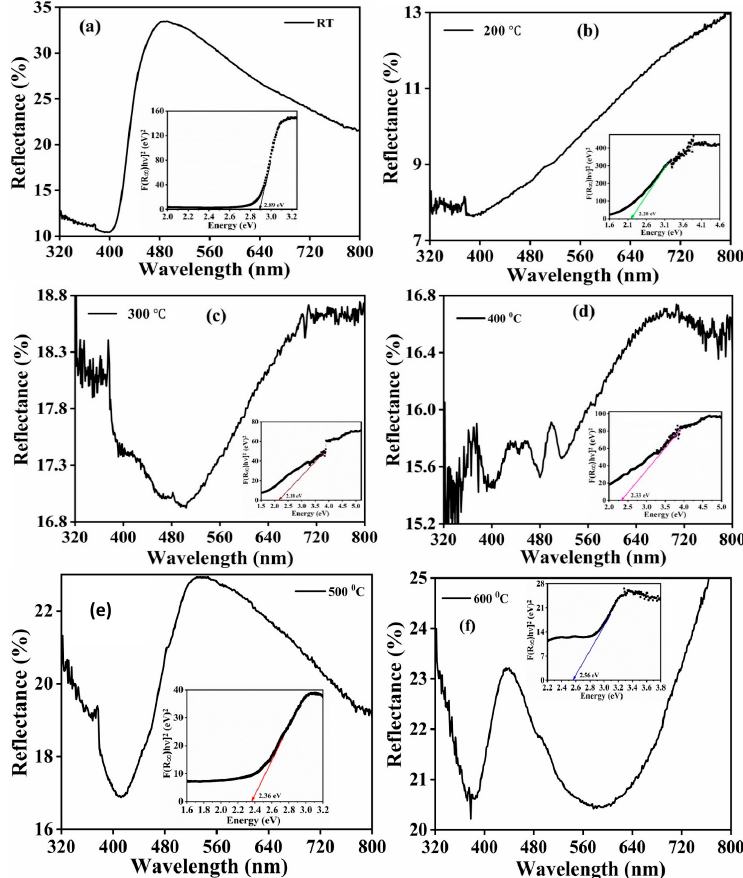
Figure 20. DR spectra of Bi 2 O 3 :Ho 3+ thin films deposited at different substrate temperatures and the inset figures are represented plots of (F(R ∞ )h ϑ ) 2 versus photon